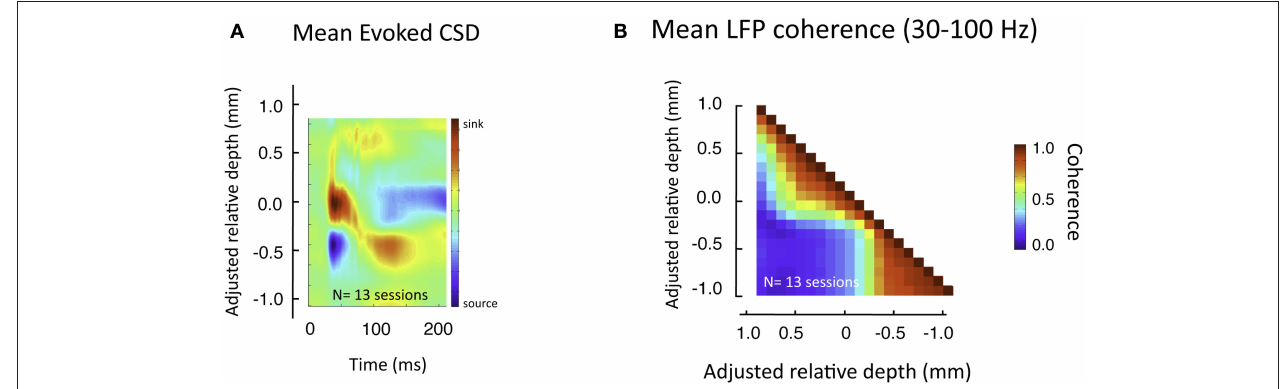
all sessions, during rest (see Figure 7 for effects of visual stimulation). The red regions reveal the high inter-compartmental coherence, with the adjacent blue regions revealing the lack of coherence between compartments.